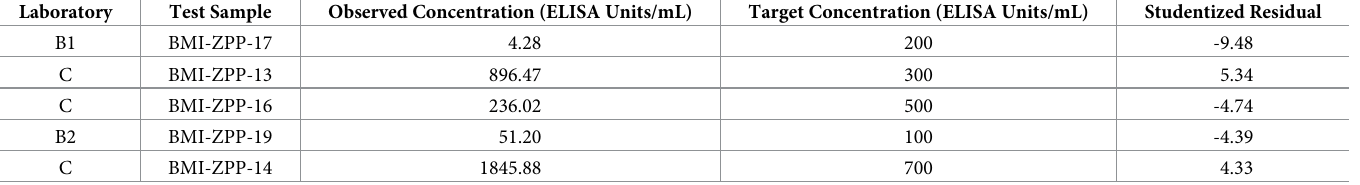
Table 4. Statistical outliers identified during analysis of intra-laboratory